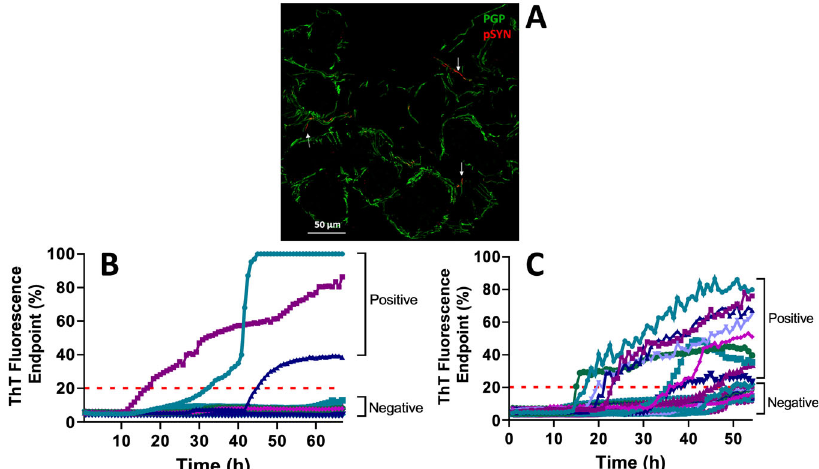
Fig. 1 IF and aSyn-SAA fi ndings. A Phosphorylated α -synuclein (p-syn) deposits in autonomic skin nerves in a patient with iRBD . Confocal microscope (400X) study of p-syn aggregates in skin nerves of a iRBD patient. Pathological p-syn deposits were found in autonomic nerves of a sweat gland. These fi bers are identi fi ed by PGP 9.5 (in green) whereas p-syn aggregates were depicted by staining the phosphorylation at Ser 129 (in red). This merged image showed that abnormal p-syn deposits correspond to PGP 9.5 staining as neuritic inclusions (arrows). B Pathological aSyn-SAA spectra of CSF from patients with RBD . The pathological α -syn seeding activity of CSF from representative iRBD patients and RBD-NT1 patients or controls was detected by RT-QuIC assay. The positive (iRBD) and negative (RBD-NT1 patients) results are de fi ned by the threshold (red dashed line) that is determined based on the average plus 4 standard deviations of non-iRBD controls. The ThT fl uorescence response started to increase at approximately 20 h in samples from the iRBD patient, but not from the RBD-NT1 patients or controls. C Skin pathological α -syn seeding activity tested by aSyn-SAA . Skin α SynP fl uorescence enhancement kinetics at each time point (0 – 55 h) from representative iRBD and control patients. The ThT fl uorescence response was similar to that found for CSF and started to increase at approximately 15 – 20 h in samples from the iRBD patients. Table 2. Diagnostic accuracy of IF and aSyn-SAA.